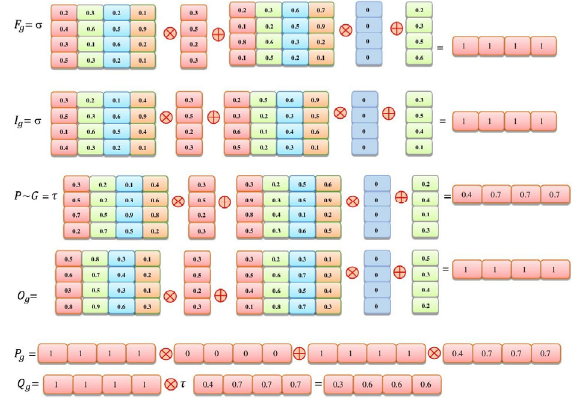
Figure 4. Calculations of various gate configurations.